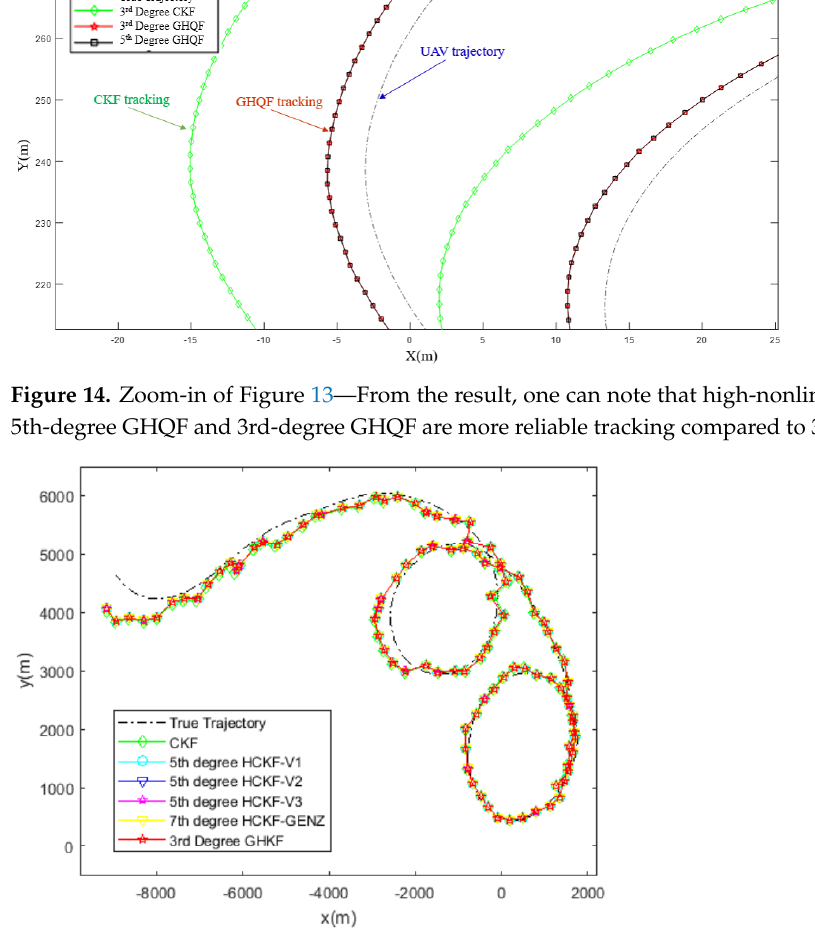
Figure 15. Experimental RFI emitter-tracking based on TDOA/FDOA measurements: Results of CKF, 5th degree HCKF-V1, 5th degree HCKF-V2, 5th degree HCKF-V3, 7th degree HCKF-GENZ, and GHkF 3rd degree compared with the true